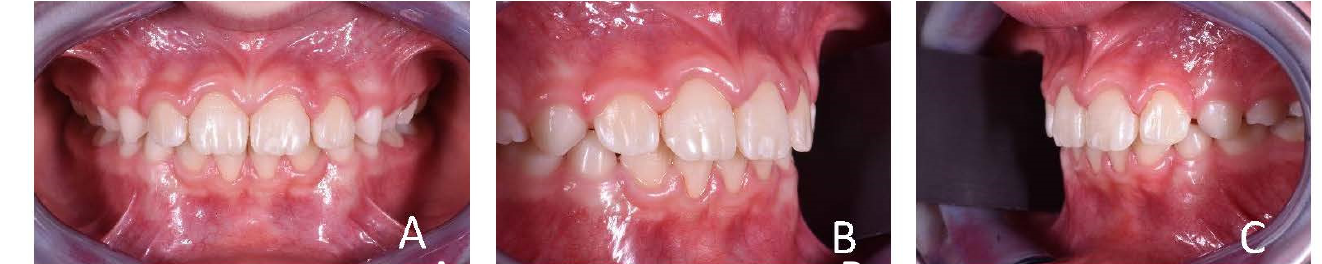
Figure 25. Intraoral photograph of the patient wearing the AMCOP OS.